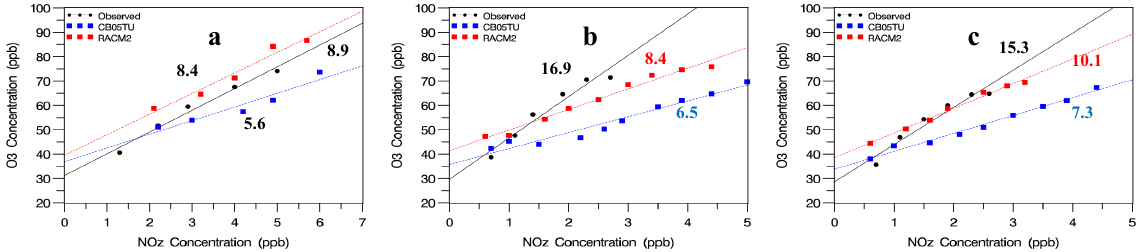
Figure 9: A comparison of ozone production efficiency with values derived from observations from the Southeastern Aerosol Research and Characterization network sites (a) Yorkville, Georgia (b) Centreville, Alabama (c) Oak Grove, Mississippi.